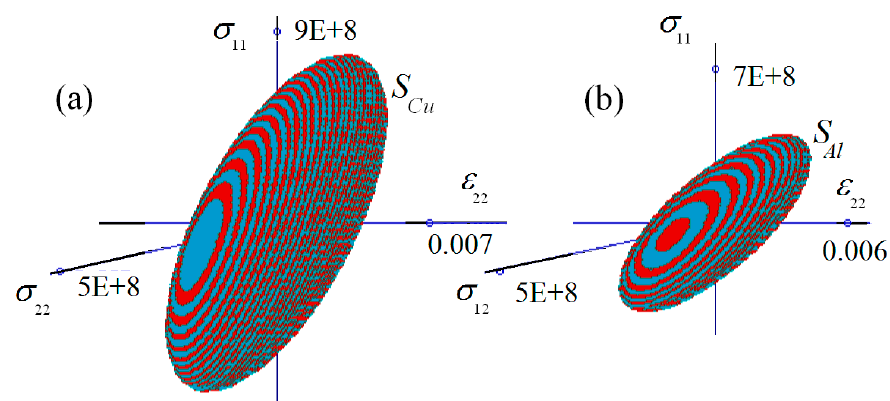
Figure 10. Failure surfaces: ( a ) pure copper, ( b ) pure aluminum.